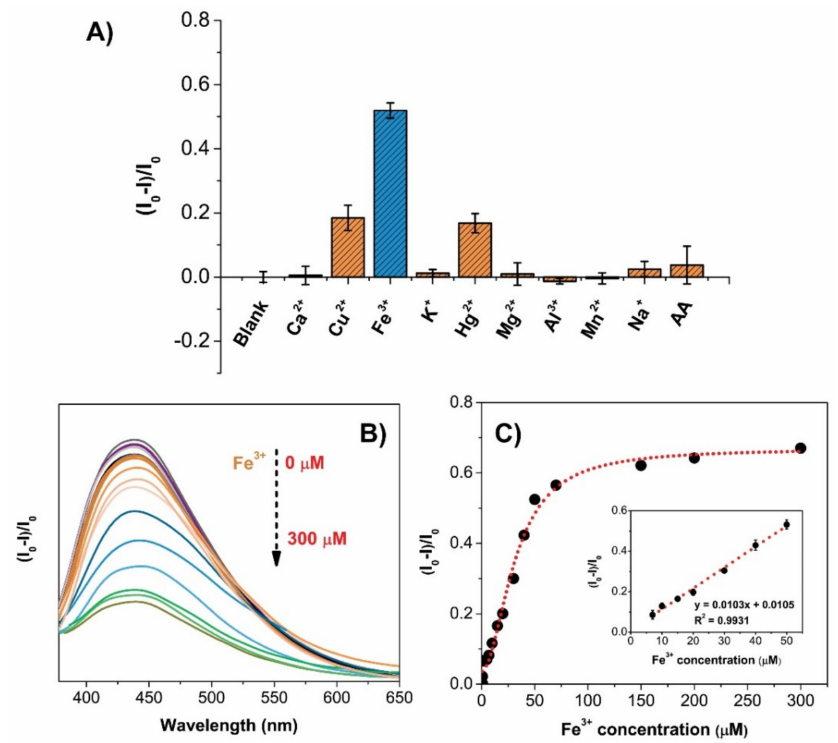
Figure 6. ( A ) Fluorescence response of CQD@Arg to different metal ions and ascorbic acid, ( B ) the flu- orescence spectral quenching upon the addition of different Fe 3+ concentrations (0.5–300 µ mol dm − 3 ); and ( C ) the relative fluorescence response ( I 0 - I )/ I 0 of CQD@Arg with the Fe 3+ addition confirming exponential behaviour (inset: linear response ranging from 7.0 to 50.0 µ mol dm − 3